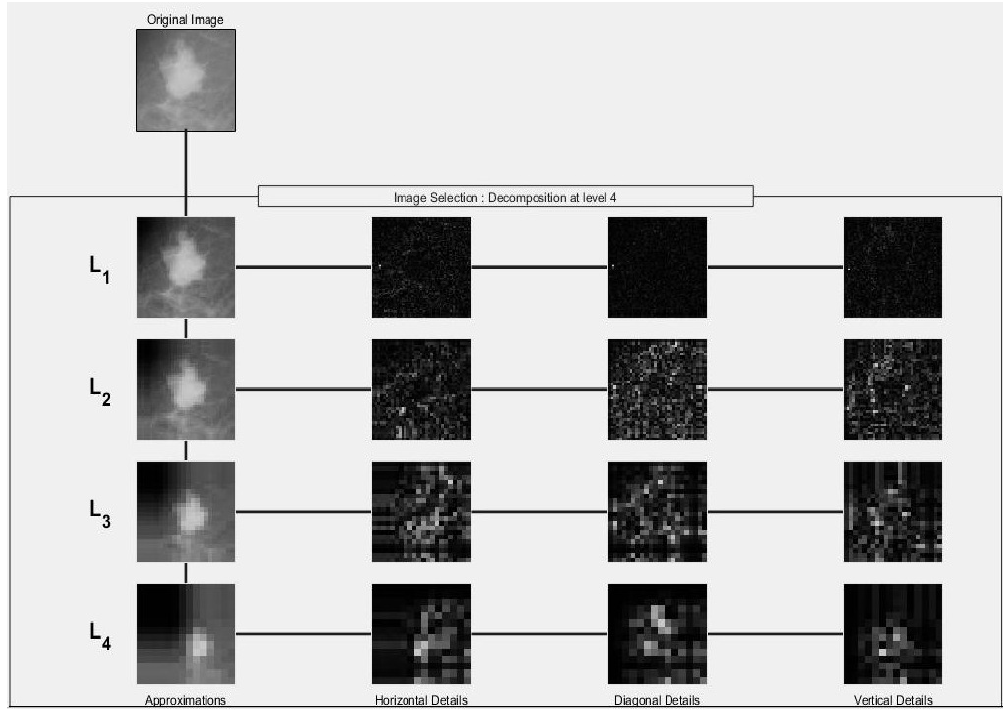
Figure 3. Four wavelet decomposition levels using Daubechies 4